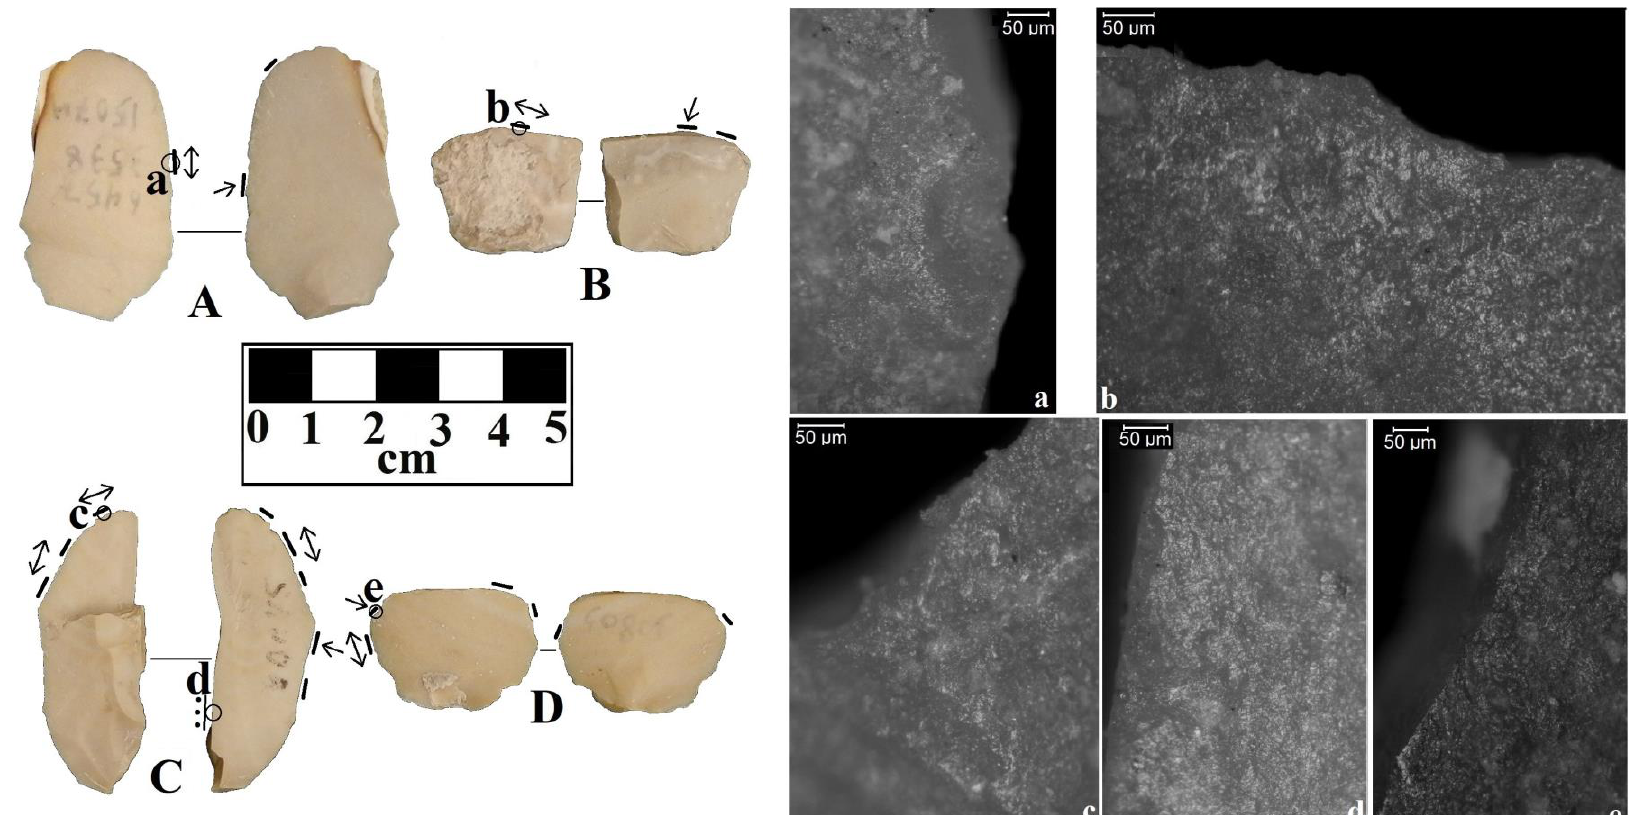
Figure 6. Dorsal (left) and ventral (right) faces of regular ( A ), Kombewa ( B ), lateral ( D ), and Tabun snap ( C ) blank types from Wadi Rabah layers ( A , C , D ) and EBA layers ( B ) at Ein-Zippori. Proximal (bulbar) end at bottom, distal end at top. White lines: extent of microwear traces, arrows: orientation of polishes and striations, white circles: locations of photomicrographs a , b , c , d & e . A : Area B, Locus 3538, Bucket 15074 (WR). Chalky cortex on part of lateral edge. B : Area B, Locus 1321, Bucket 13266. Cortex and caliche on dorsal face. C : Area C, Locus 1996, Bucket 90045. D : Area E, Locus 3135, Bucket 30805, item #1. Caliche on dorsal face. a : bright bone and rough hide or meat polish on right lateral edge (dorsal) sharp edge-angle (20 ᵒ ) on A from cutting and scraping of meat, fresh hide or both. b : rough hide or meat polish on distal edge (dorsal) of B with steeper edge angle (45 ᵒ ) from expedient meat or fresh hide cutting and scraping. c : bright bone or stone and rough hide or meat polish on thin distal left lateral edge (E.A. 25 ᵒ ) above Tabun snap on C . d : possible prehension traces on proximal left lateral edge (ventral) of C. Thin edge was used for cutting meat or hide, thicker edge was used for scraping meat or fresh hide, and possibly bone. e : bright bone or stone and rough hide or meat polish on thin (E.A. 20 ᵒ ) distal left lateral edge (dorsal) of D also used for expedient meat or hide cutting and scraping where bones may have been “nicked.” Microwear was not very well-developed on any blanks. All photomicrographs 187.5x, scales are 50